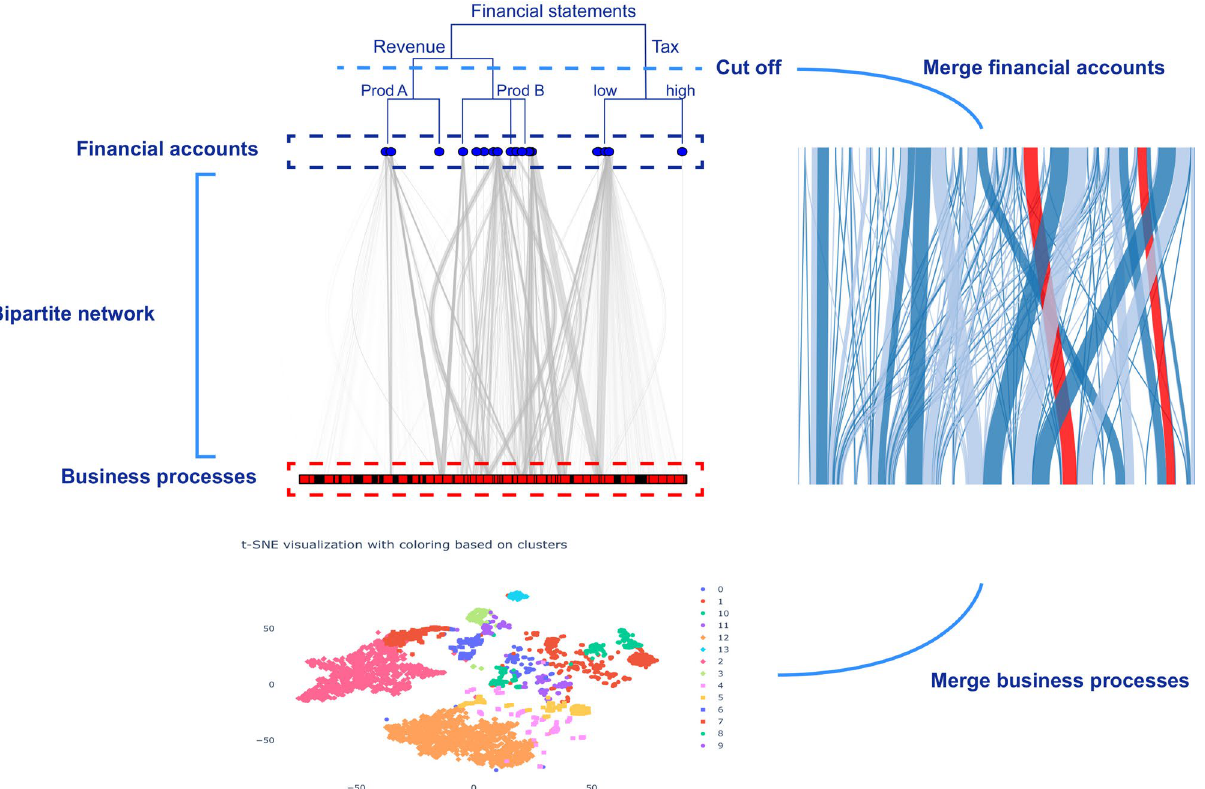
Figure 2. The bipartite network extracted from the transaction data. The blue nodes represent the financial accounts and the red nodes the business processes. On top of the blue nodes we show the